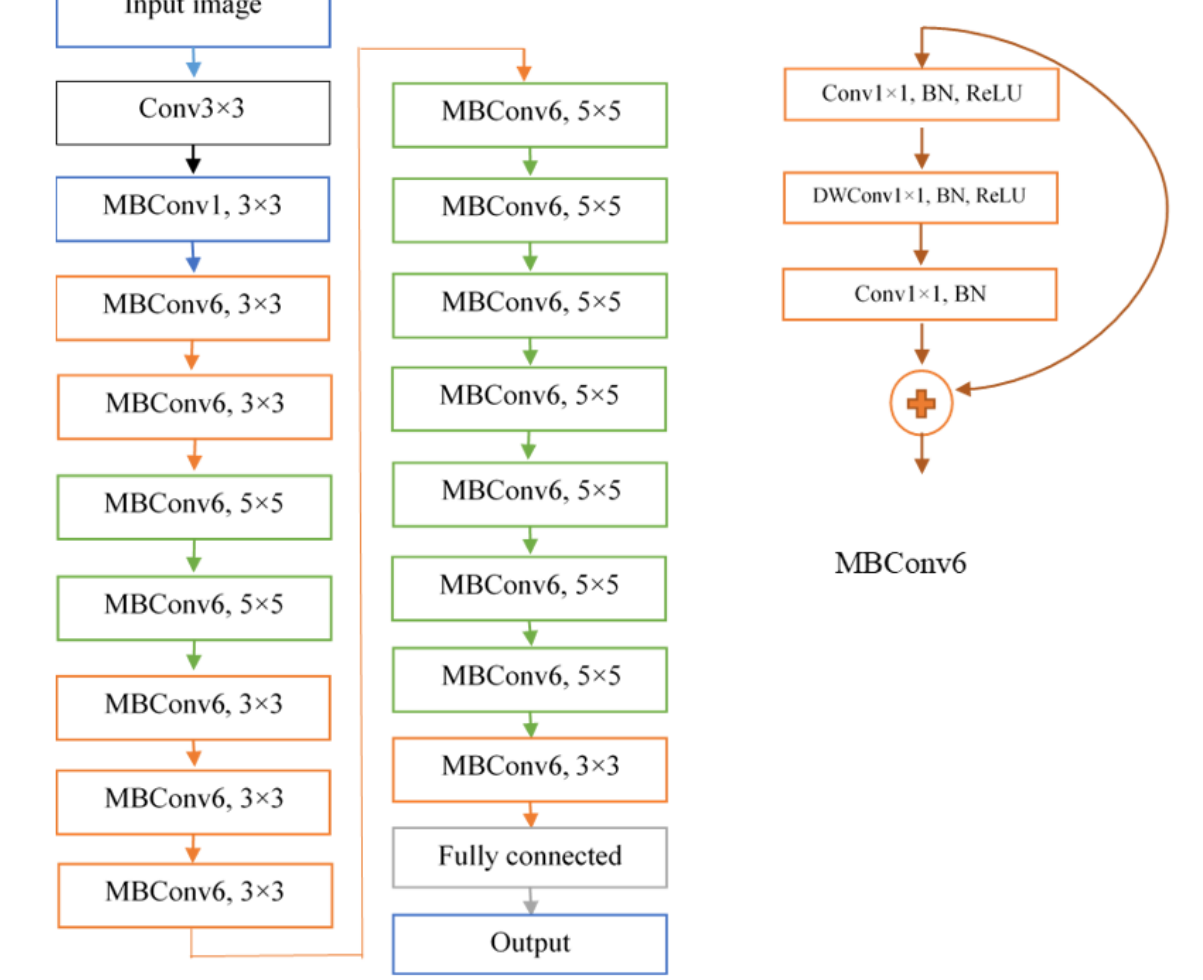
Figure 4. Schematic representation of DeepARRNet.